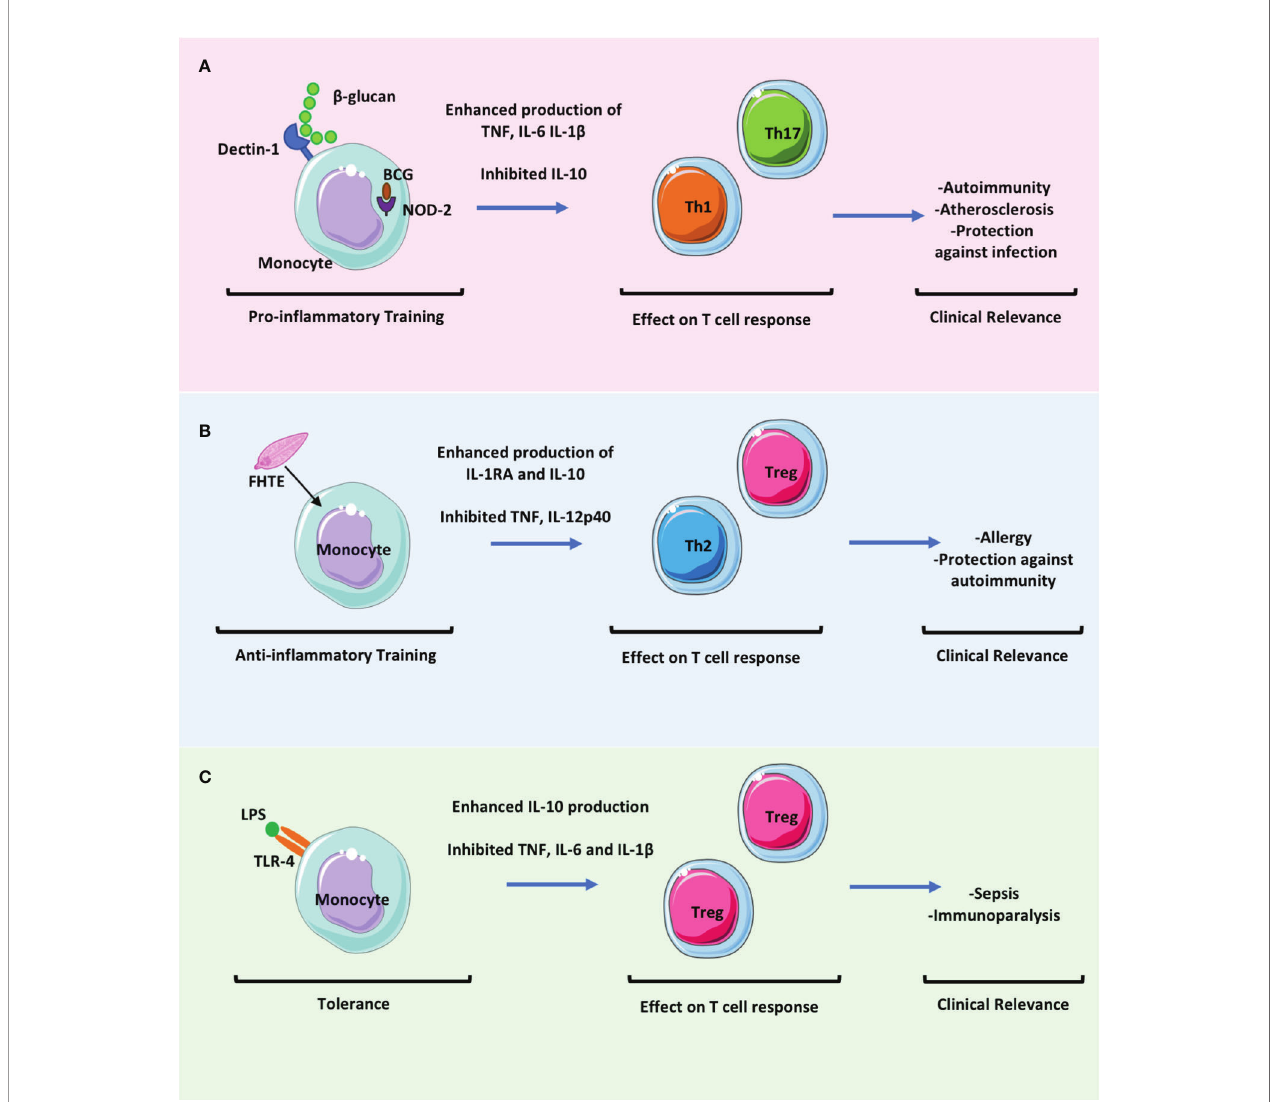
FIGURE 2 | The effect of trained immunity on T cell responses will be key to determining the clinical relevance of trained immunity in mediating protection versus pathology. Trained immunity likely has an impact in many settings of infectious diseases and in immune mediated pathology. These clinically relevant effects may be mediated directly by the altered immune responses of myeloid cells but also indirectly by the effects of these myeloid cells on adaptive immune responses. (A) Trained immunity induced by b -glucan or BCG results in enhanced proin fl ammatory monocyte function which may promote the activation and differentiation of Th1 and Th17 cells whilst concomitantly downregulating Treg cell responses. This may be bene fi cial in promoting protection against infection but may be pathogenic in settings of immune mediated pathology such as in autoimmunity or atherosclerosis. (B) Fasciola hepatica total extract (FHTE) induces trained immunity which results in enhanced anti-in fl ammatory responses. This may be bene fi cial in attenuating autoimmune diseases but may promote cancer or allergy. (C) LPS induced trained immunity followed by restimulation with LPS results in tolerance. This induces Treg cells and is thought be pathological during